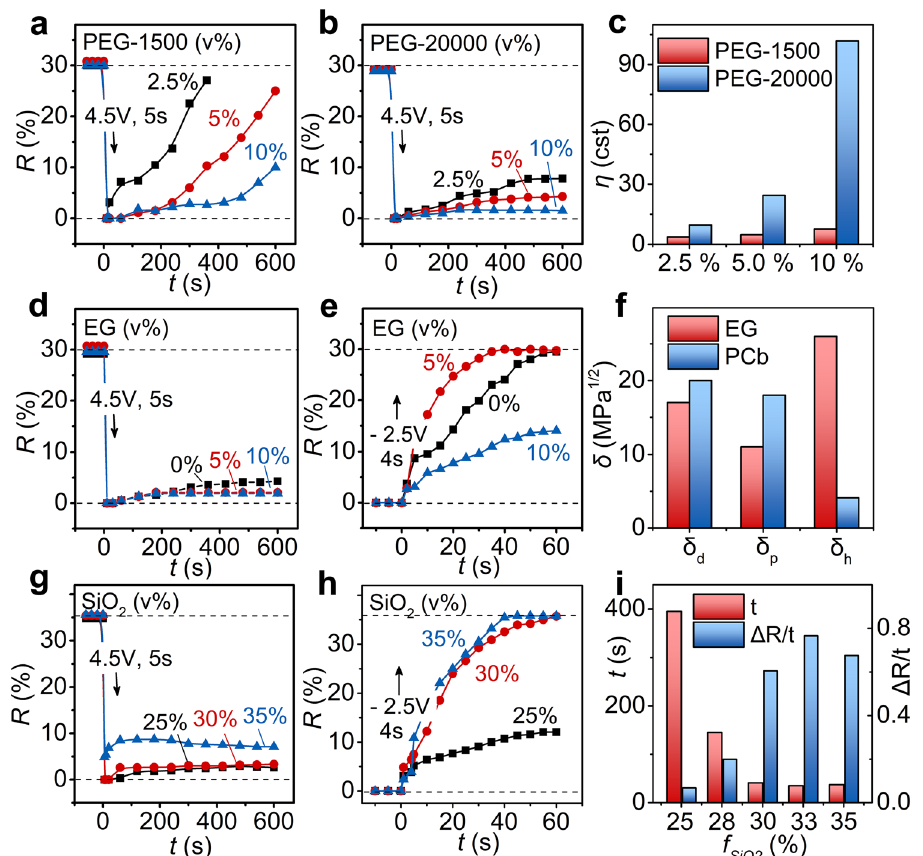
Fig. 2 | Optimizing the recipe of bistable ERPC. a , b In fl uence of PEG volume fraction and molecular weight on the holding of colorless state, indicated by the timeevolutionofre fl ectionintensitiesand explainedby c themeasured viscosities of PCb-PEG mixtures; d , e in fl uence of EG volume fraction on the holding of